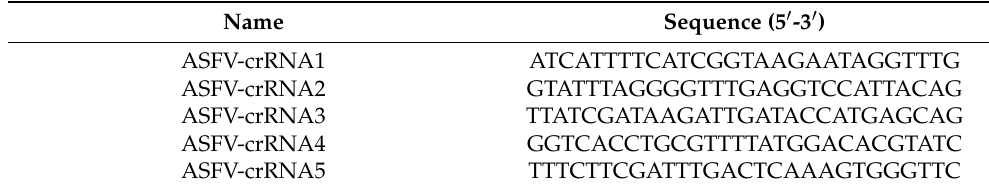
Table 2. Sequences of clustered regularly interspaced short palindromic repeats RNAs